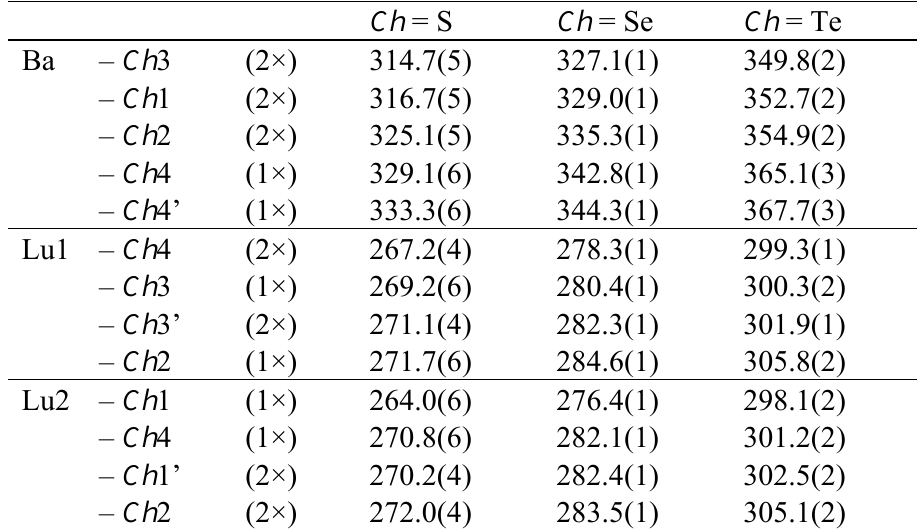
Table 2. Selected internuclear distances ( d /pm) for the three BaLu ( Ch = S, Se and